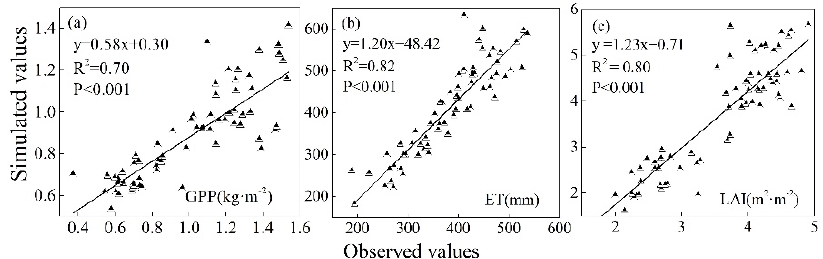
Figure 2. Comparisons between the observed (x) and simulated (y) values of annual ( a ) gross primary productivity (GPP), ( b ) evapotranspiration (ET), and ( c ) leaf area index (LAI) of the Loess Plateau from 2001 to 2020.